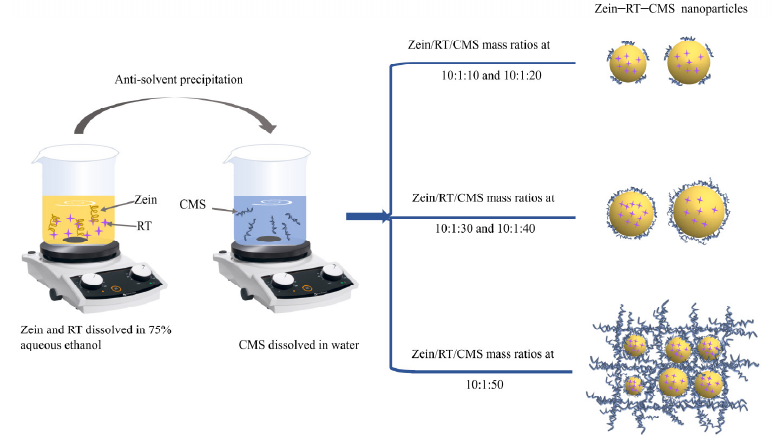
Figure 10. Possible formation mechanism of zein–RT–CMS nanoparticles.